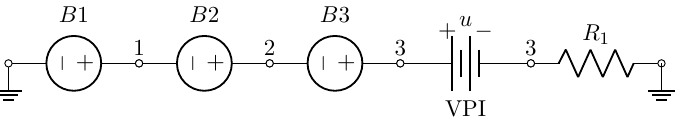
Figure 11. Circuit equivalent to equation Parabolic Mirror Figure 12. Circuit equivalent to equation Parabolic